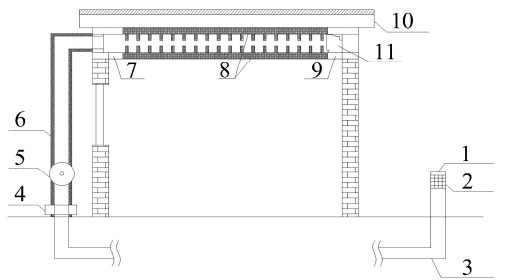
Figure 1. Composition of the experimental room (1-Outdoor air inlet, 2-Air filer, 3-Air duct, 4-Dehumidifier, 5-Duct fan, 6-Insulation, 7-Ceiling fan 2, 8-PCM ceiling, 9-Ceiling fan 1, 10-Roof, 11-Ceiling exit duct).